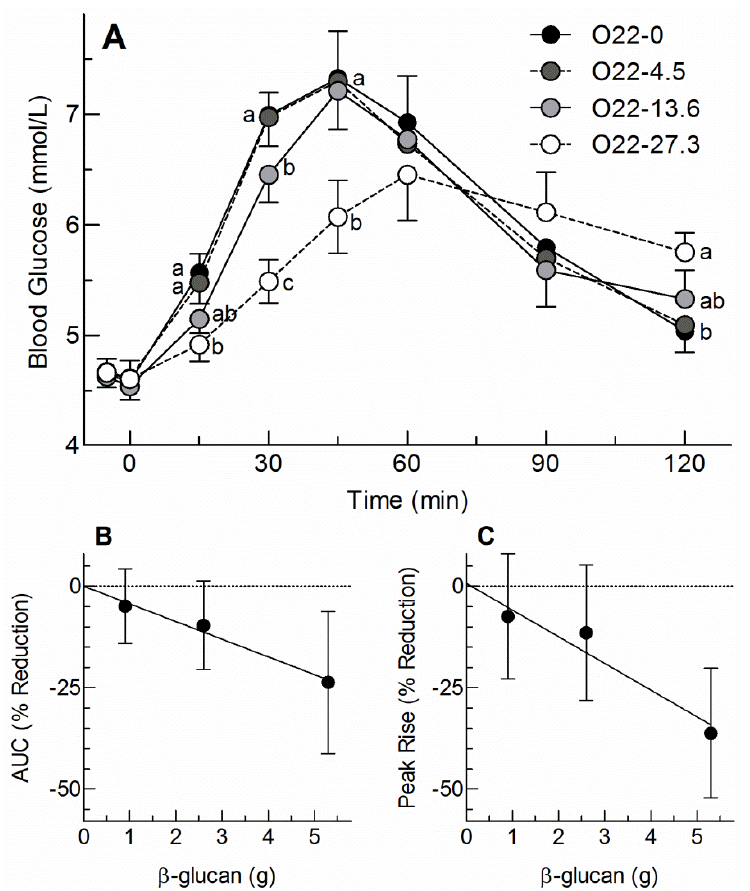
Figure 1. Panel ( A ): Blood glucose concentrations after taking 0, 4.5, 13.6 and 27.3 g, respectively, of OatWell ® 22 (O22-0, O22-4.5, O22-13.6 and O22-27.3) at − 5 min followed by 50 g available carbohydrate from white bread at 0 min. Values are means ± SEM for n = 10 subjects. a–c Means at the same time containing different letters within the superscripts differ significantly by Tukey’s test p < 0.05; ( B , C ): Percentage reduction from control in incremental areas under the curve (AUC); ( B ) and peak rise in blood glucose; ( C ) after taking 0, 4.5, 13.6 and 27.3 g of OatWell ® 22 (containing 0, 0.9, 2.6 and 5.3 g oat β -glucan, respectively) at − 5 min followed by 50 g available carbohydrate from white bread at 0 min. Values are means ± 95% confidence interval for n = 9 or 10 subjects (after excluding outlying values).